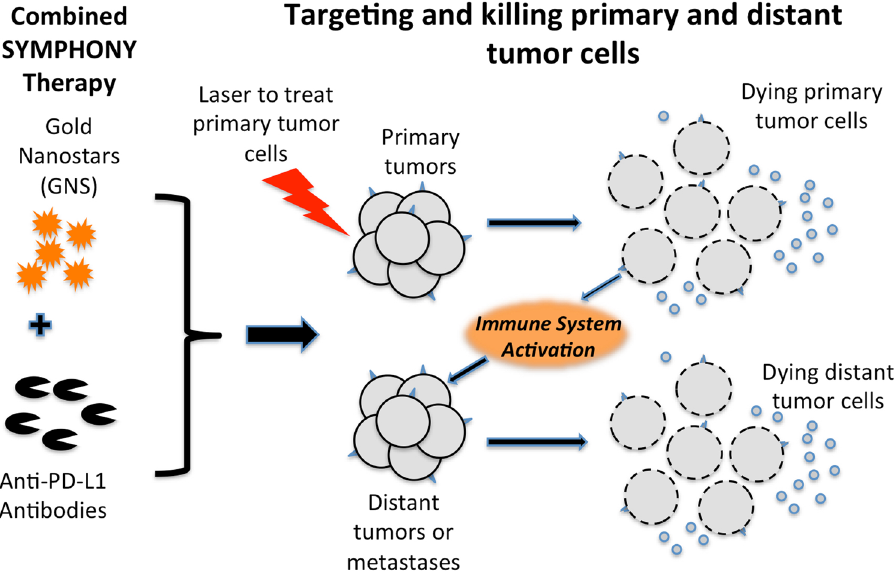
Figure 1. SYMPHONY: Synergistic Immuno Photothermal Nanotherapy. By disabling the tumor immune resistance using anti-PD-L1 antibodies and simultaneously ablating individual cancer cells using GNS-enabled photothermal therapy, SYMPHONY can trigger a powerful thermally enhanced systemic immune activation to rapidly eradicate locally aggressive as well as distant metastatic